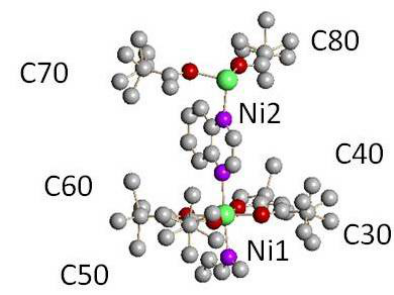
Figure 6. Ball-and-stick model of trans -[Ni(tmhd) unit. A plane of symmetry bisects a quinoxaline molecule on Ni1 and an i symmetry element lies on Ni2. All but one tert -butyl groups, designated by the central carbon atoms, show two-fold disorder, see Table 2. The hydrogen atoms are not included for clarity (C, gray; Ni, green; N, purple; O, red)